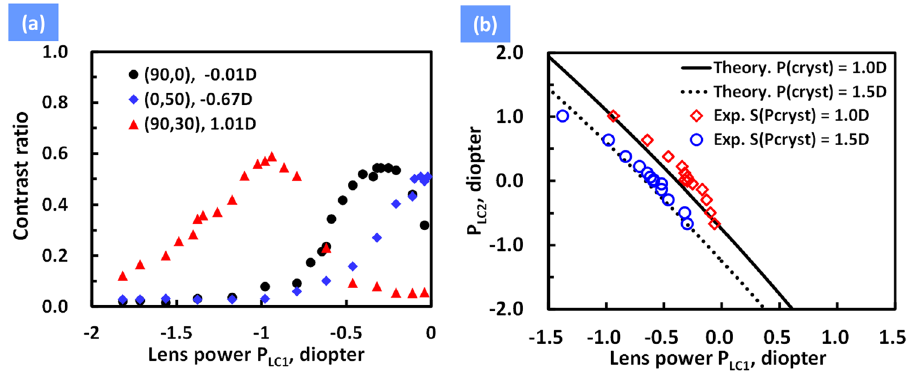
Figure 6. ( a ) The contrast ratio as a function of applied voltage V 1 of “LC lens 1” at V 2 = 75 V rms (2 kHz) at different lens power of “LC lens 2”. ( b ) Lens power of “LC lens 2”( P LC 2 ) as a function of lens power of “LC lens 1”( P LC 1 ) for S ( P cryst ) = 1D and 1.5D. Circles and diamonds stand for experimental results. Black solid line and dotted line stand for theoretical